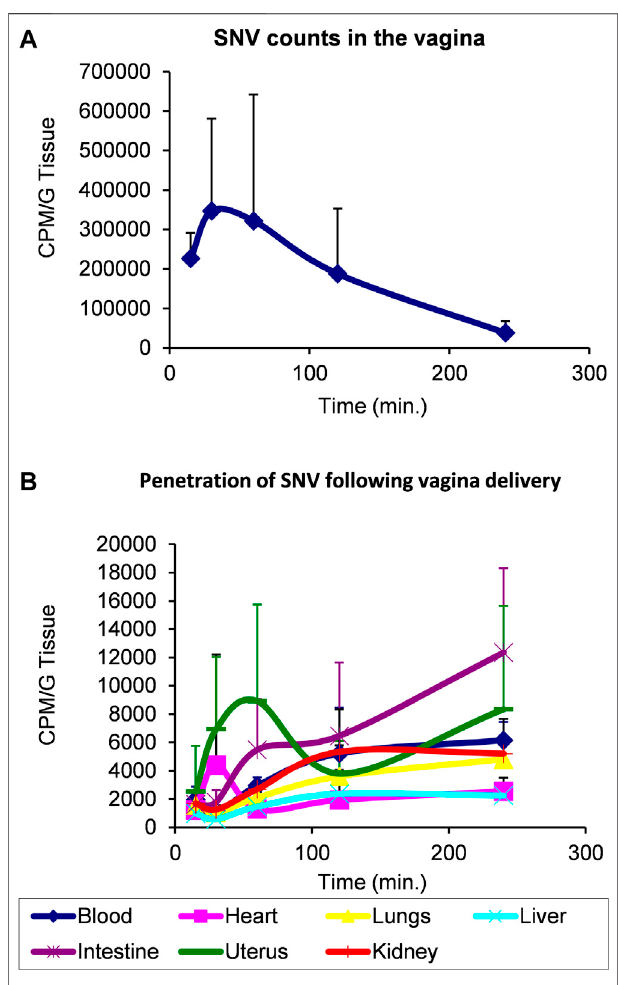
FIGURE 5 | SNV demonstrated a high transepithelial penetrability and stability using a model of vaginal delivery in rats. 7.0 microCi/rat (15 million CPM, 100 Ci/mmole speci fi c activity) of radioactive SNV was delivered in the vagina of rats at T0. Each point on the chart represents at least two rats. Levels of radioactivity were monitored over 250 min to assess the remaining amount of SNV in the vagina (A) versus its distribution in the indicated organs (B) as a measure of its penetrability through the vaginal epithelium. Data are Mean ±